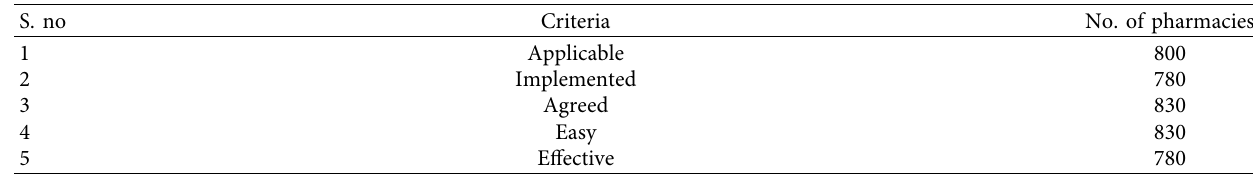
Table 1: Data for the pharmacies to adopt